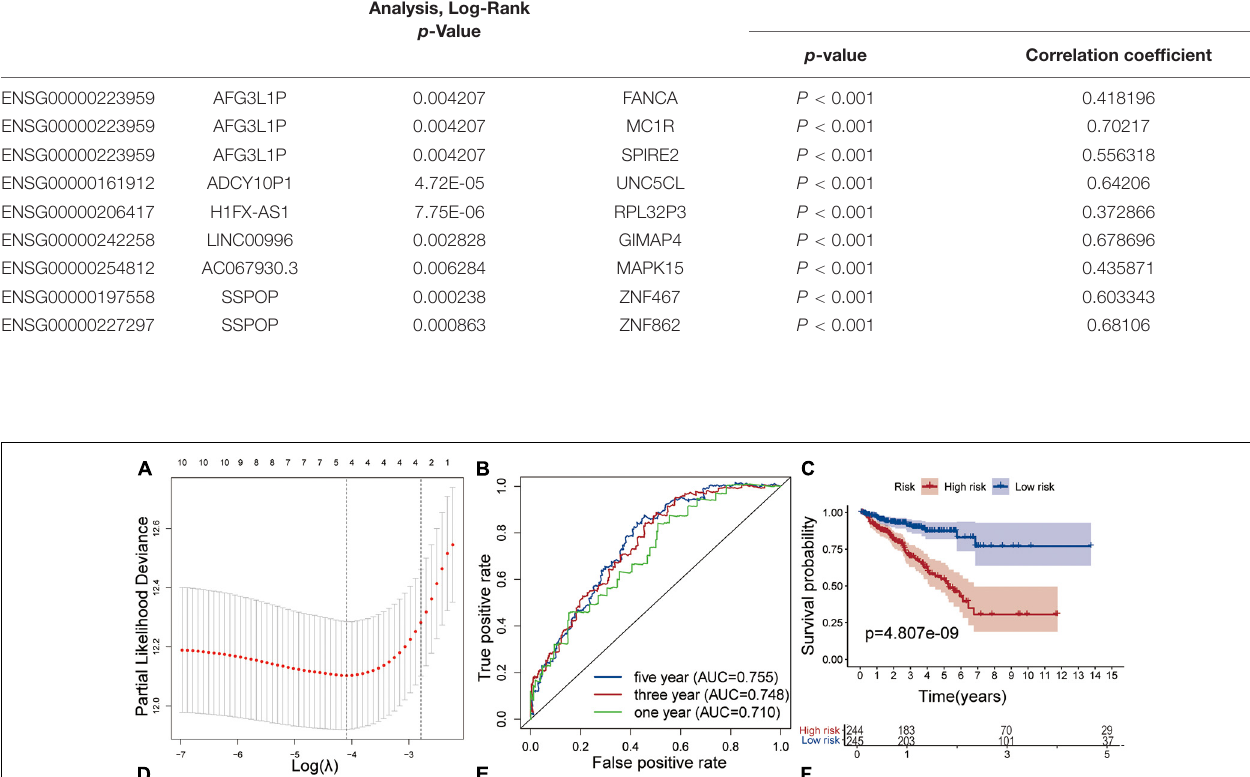
TABLE 2 | List of eRNAs and eRNAs-driven genes associated with overall survival derived from enhancers. Ensembl ID Symbol TANRIC Overall Survival Target gene Correlation between lncRNA and the Neighboring Target Analysis, Log-Rank p -value Correlation coefficient